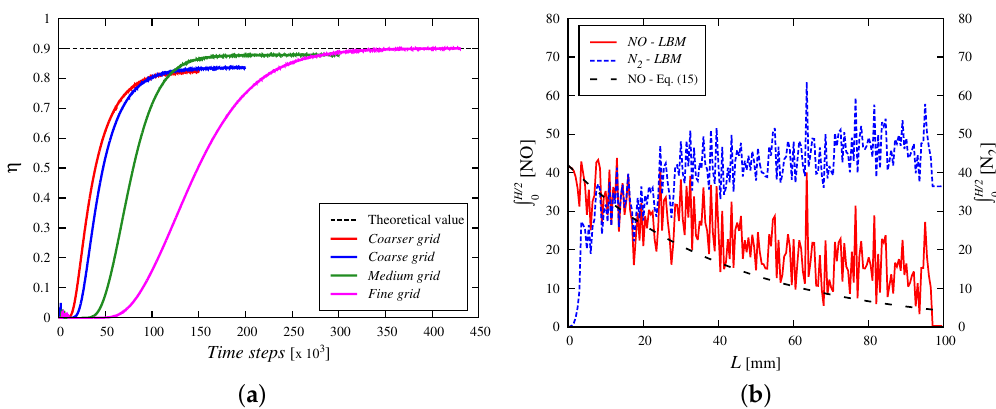
Figure 5. ( a ) conversion efficiency vs. simulation time for the different grid sizes, compared to the theoretical expected value; ( b ) species concentration along the SCR axis, at t = 250,000 time steps and for the 3000 × 200 grid, compared to the plug-flow reactor